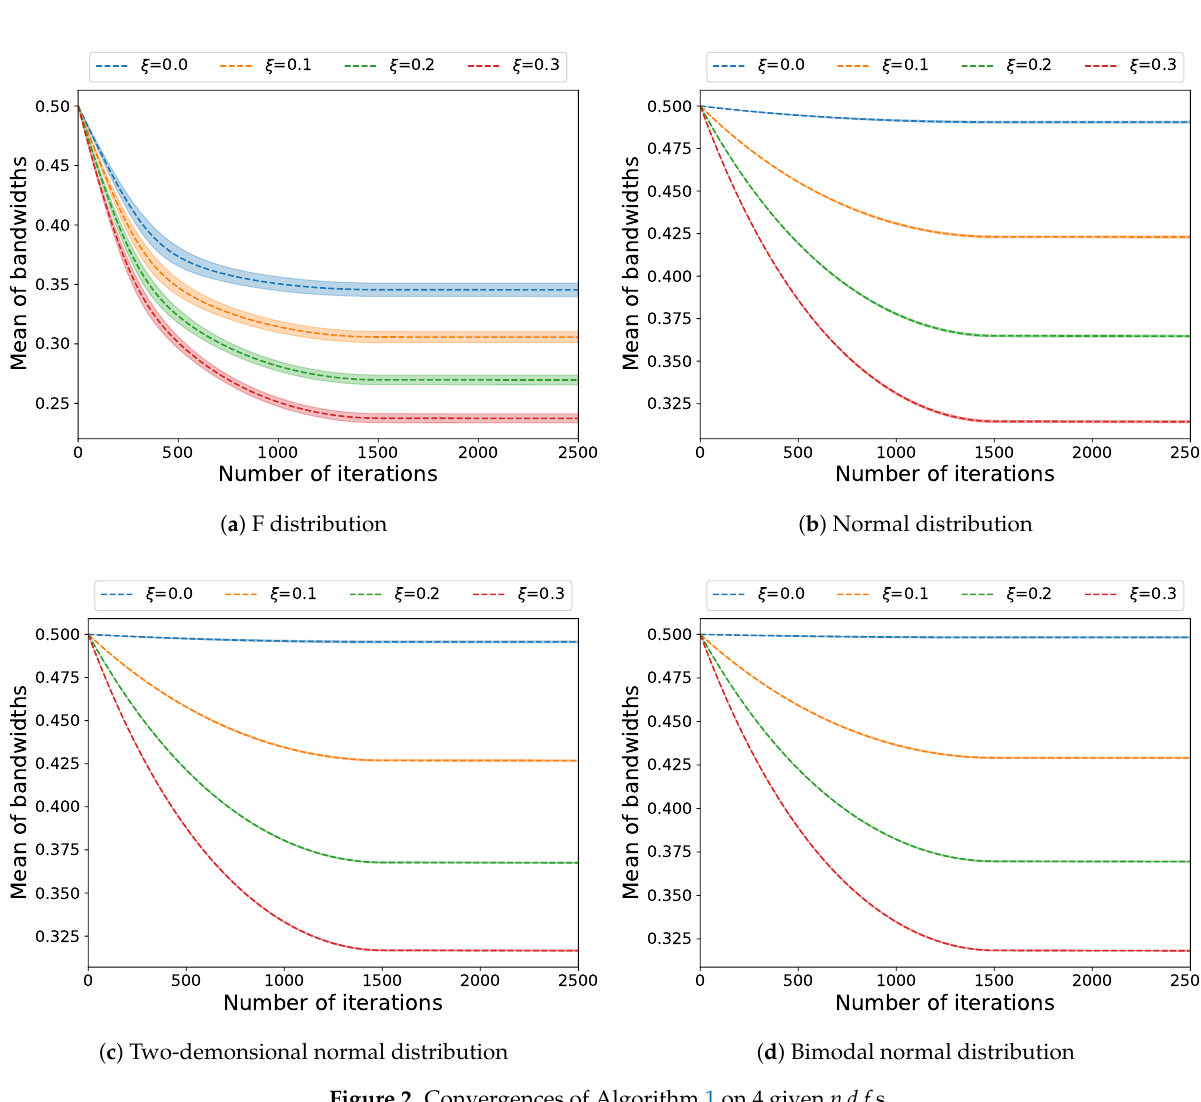
Figure 2. Convergences of Algorithm 1 on 4 given p.d.f. s.